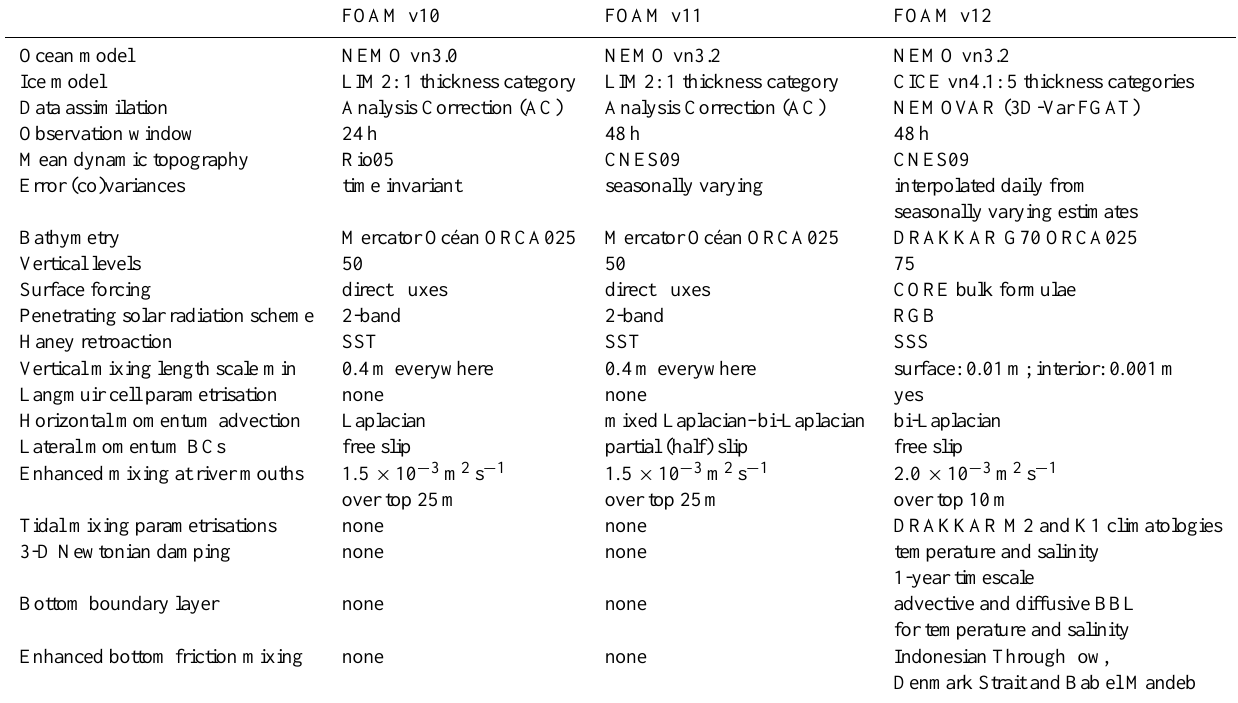
Table 1. Differences between the Global FOAM configuration in the new v12 system, the previous v11 system and the v10 system of Storkey et al. (2010).